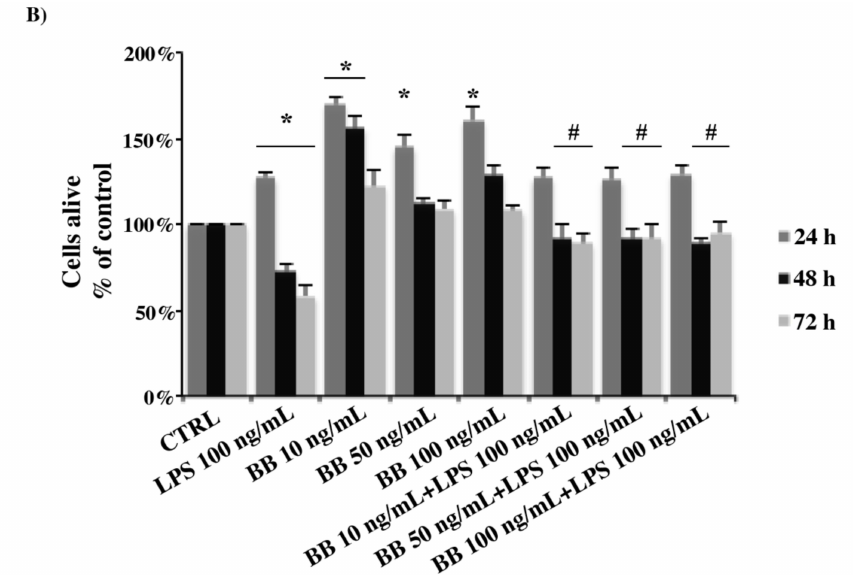
Figure 2. Analysis of cell viability evaluated by 3-(4,5-dimethylthiazol-2-yl)-2,5 diphenyltetrazolium bromide (MTT) assay ( A ) and Trypan blue exclusion test ( B ). Cells were treated with 10, 50 or 100 ng / mL BB extract in the absence or presence of 100 ng / mL lipopolysaccharide (LPS). Data were reported as percentage normalized to the control values and are mean ± SD of at least three independent experiments. * p < 0.05 compared to the same time points control, # p < 0.05 compared to the same time points LPS.